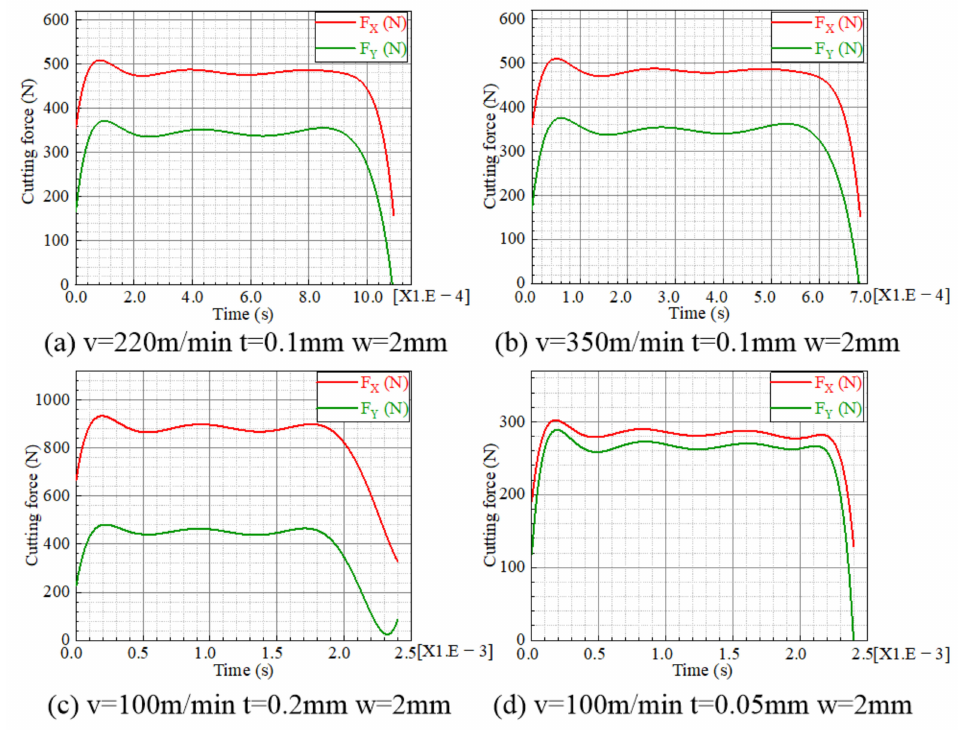
Figure 3. Cutting-force curves. ( a ) V = 220 m/min t = 0.1 mm w = 2 mm, ( b ) V = 350 m/min t = 0.1 mm w = 2 mm, ( c ) V = 100 m/min t = 0.2 mm w = 2 mm, ( d ) V = 100 m/min t = 0.05 mm w = 2